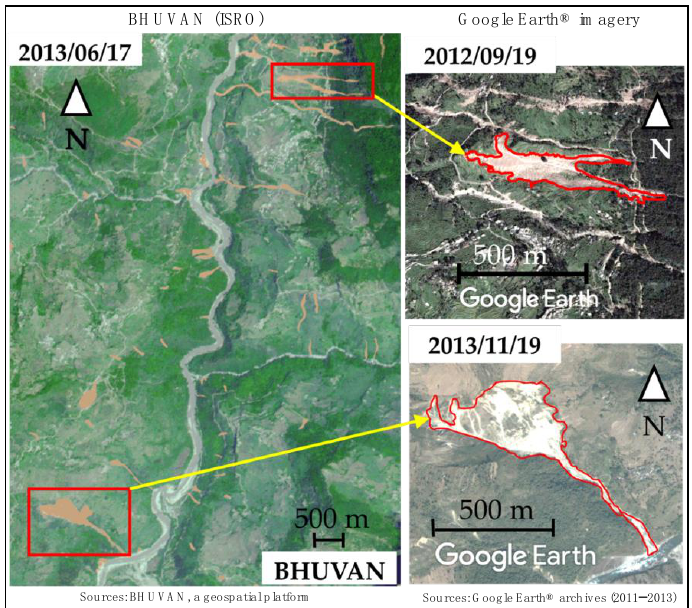
Figure 2. An example of the landslide’s identification from BHUVAN (a geospatial platform) (http://bhuvan.nrsc.gov.in (accessed on 2 August 2020)) and digitization of landslides from Google Earth ® imagery.